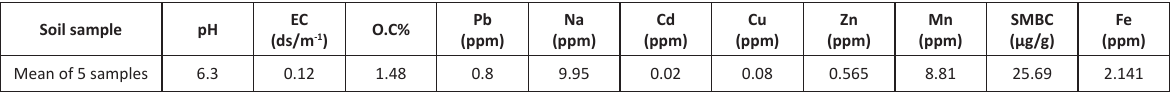
Table 1. Results of chemical analysis of soil collected from the habitat of Eriolaena lushingtonii Soil sample pH